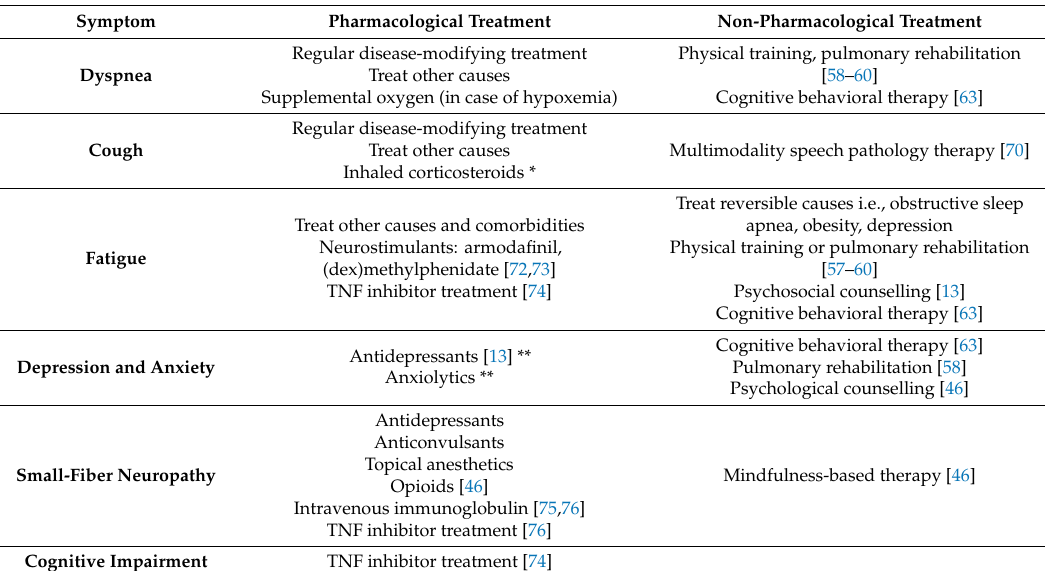
Table 1. Overview of pharmacological and non-pharmacological treatment options for common sarcoidosis symptoms. Many of these recommendations are expert opinion or based on small